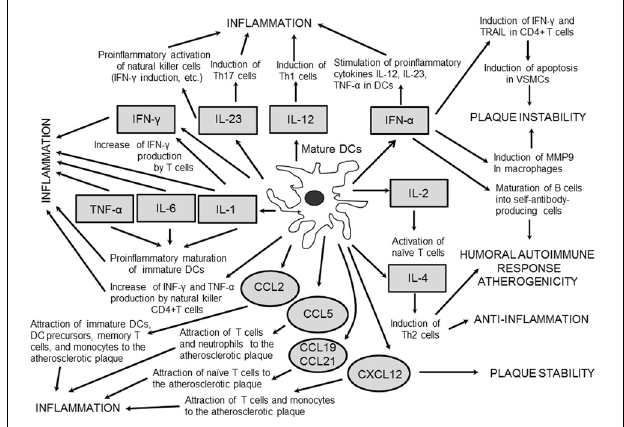
FIGURE 2 | Cytokines and chemokines produced by mature DCs in the atherosclerotic vessels. DC-derived cytokines mostly possess proinflammatory and proatherogenic properties. Chemokines secreted by mature DCs stimulate chemotaxis of a variety of immune cells to attract them to the atherosclerotic